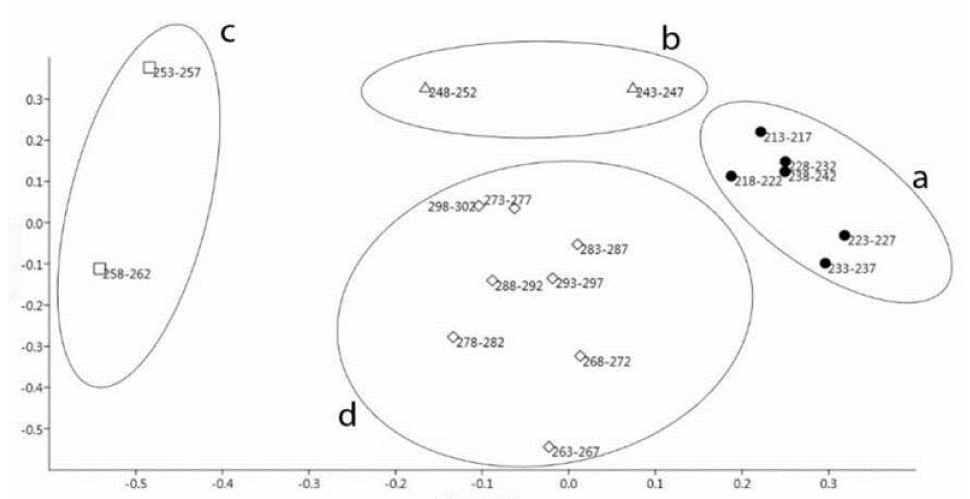
Figure 2. Grouping of activity data according to the results of PCoA ( a —Before Rut (BR), 1 August– 30 August; b —First Half of Rut (FHR) 31 August–9 September; c —Second Half of Rut (SHR) 10 September–19 September; d —After Rut (AR), 20 September–29 October). Regarding the 5-day sections defined according to the conception curve, the main periods BR (Figure 2a; D 213-242 ) and AR (Figure 2d; D 263-302 ) are clearly distinguishable both from each other and from the main period Rut. However, data in the main period Rut do not form a homogenous group, hence the division of the two periods, thus creating the main periods FHR (Figure 2b; D 243-252 ) and SHR (Figure 2c; D 253-262 ). In the next step, activity and conception index data were compared for the four main periods (Figure 3).